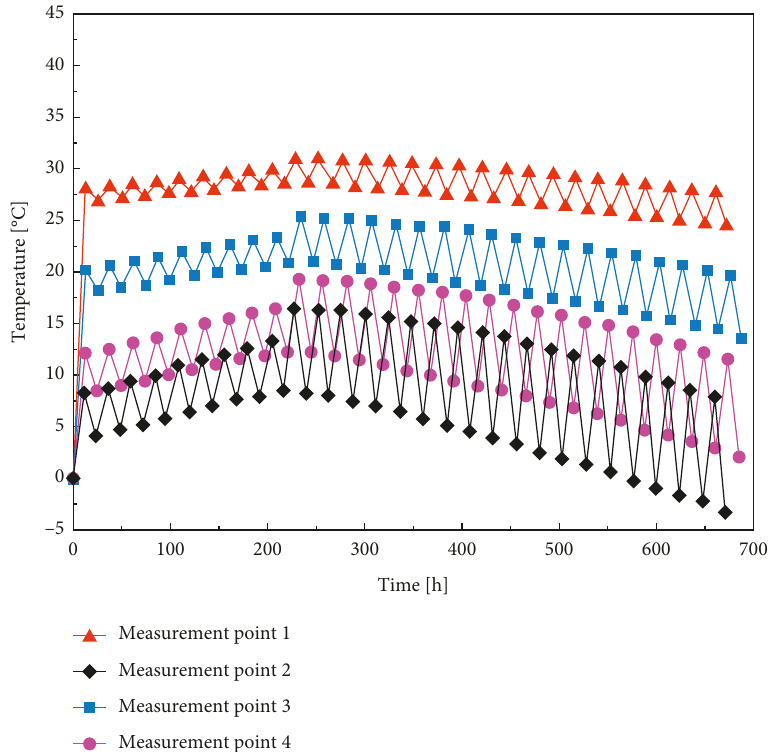
Figure 11: SVM predicts the temperature at each measuring point in the SVM-predicted